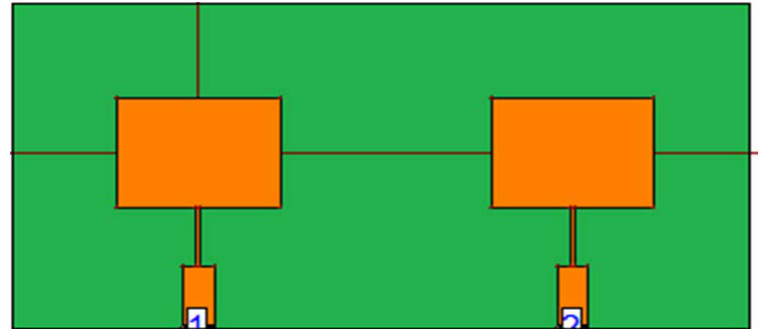
Figure 2. Schematic of setup of conventional microstrip antenna array for mutual coupling measurement.